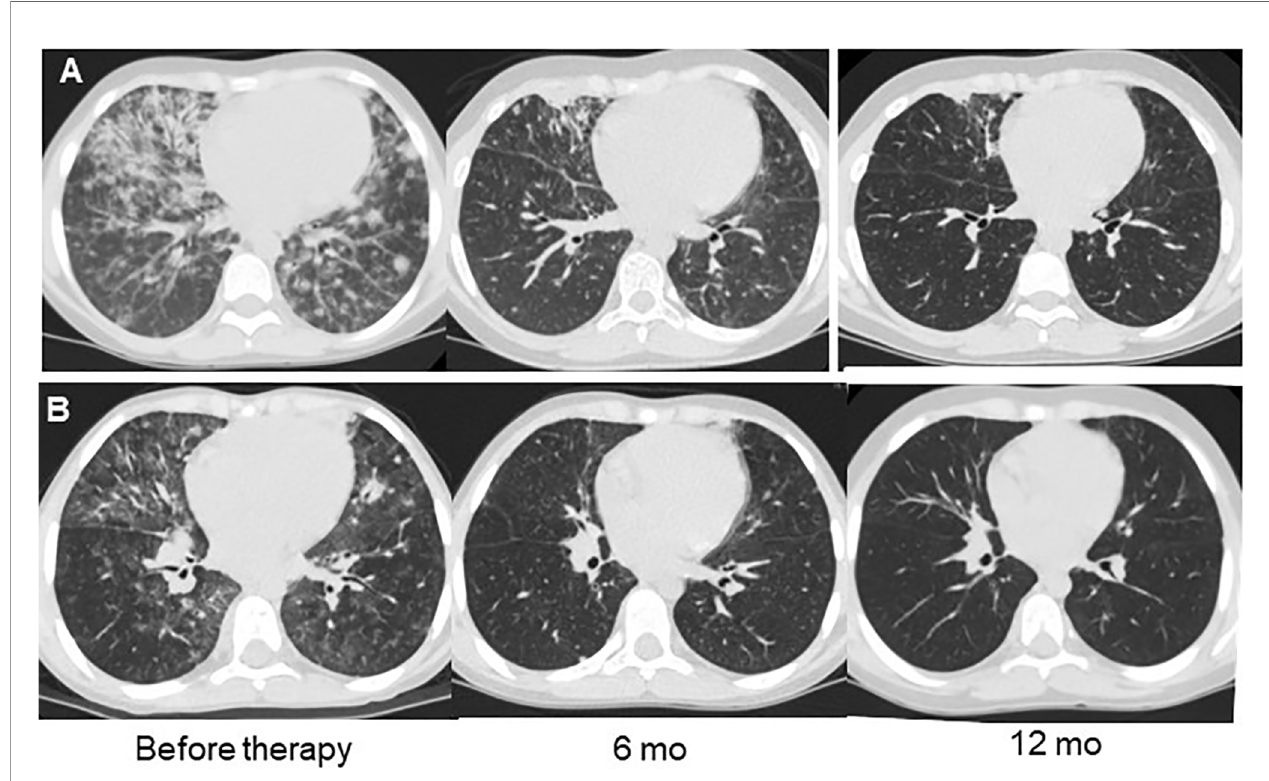
TABLE 1 | The ILLD variants and response to therapy in Groups 1 and 2. Variant of ILLD Patients, n